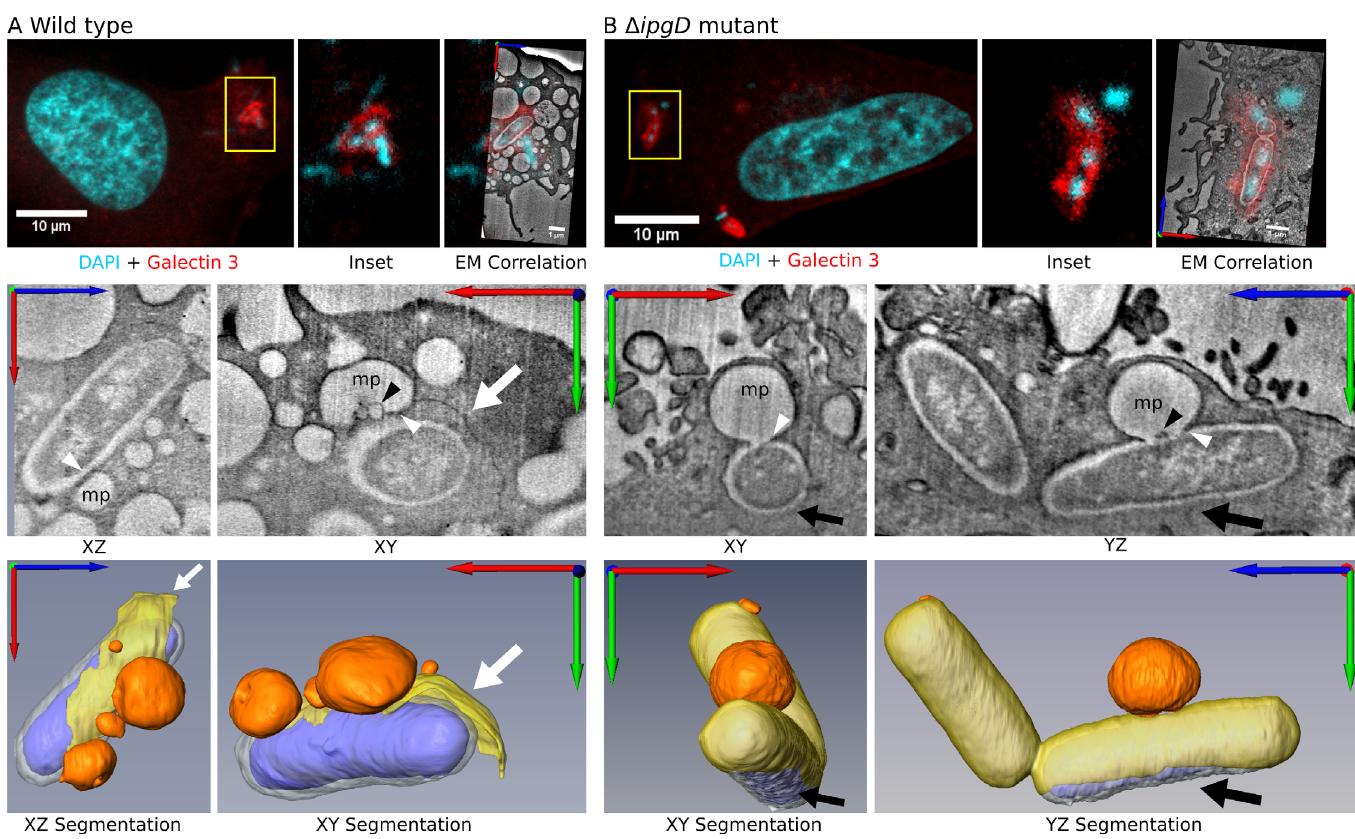
Fig 5. Macropinosomes come into direct contact with the bacteria containing vacuole during vacuolar rupture. Vacuolar rupture occurring during of WT and Δ ipgD infections was studied using C-FIB/SET. Confocal microscopy was used to identify bacteria (cyan) within rupturing BCVs labeled by galectin- 3-mOrange (red). (A) 3D ultrastructural data of WT reveals several macropinosomes (mp, orange) in direct contact (white arrow heads) with the BCV membrane (yellow), surrounding the bacteria (blue -cytosol, white- LPS). A dissociated BCV membrane is observed (A, white arrow) as well as smaller intraluminal vesicles within the macropinosome (A, black arrowhead). See also S8 Movie. (B) The Δ ipgD strain exhibits less vesicles in contact with the BCV than the Δ ipgD mutant strain, yet contact morphology is maintained (white arrow heads). Rupture on the opposing end to the contact point is observed (black arrow). See also S9 Movie. Overall 15 FIB/SET data sets of invasion sites were acquired (11 WT, 4 Δ ipgD) . For each strain, a representative data set of a site containing a rupturing BCV is presented.